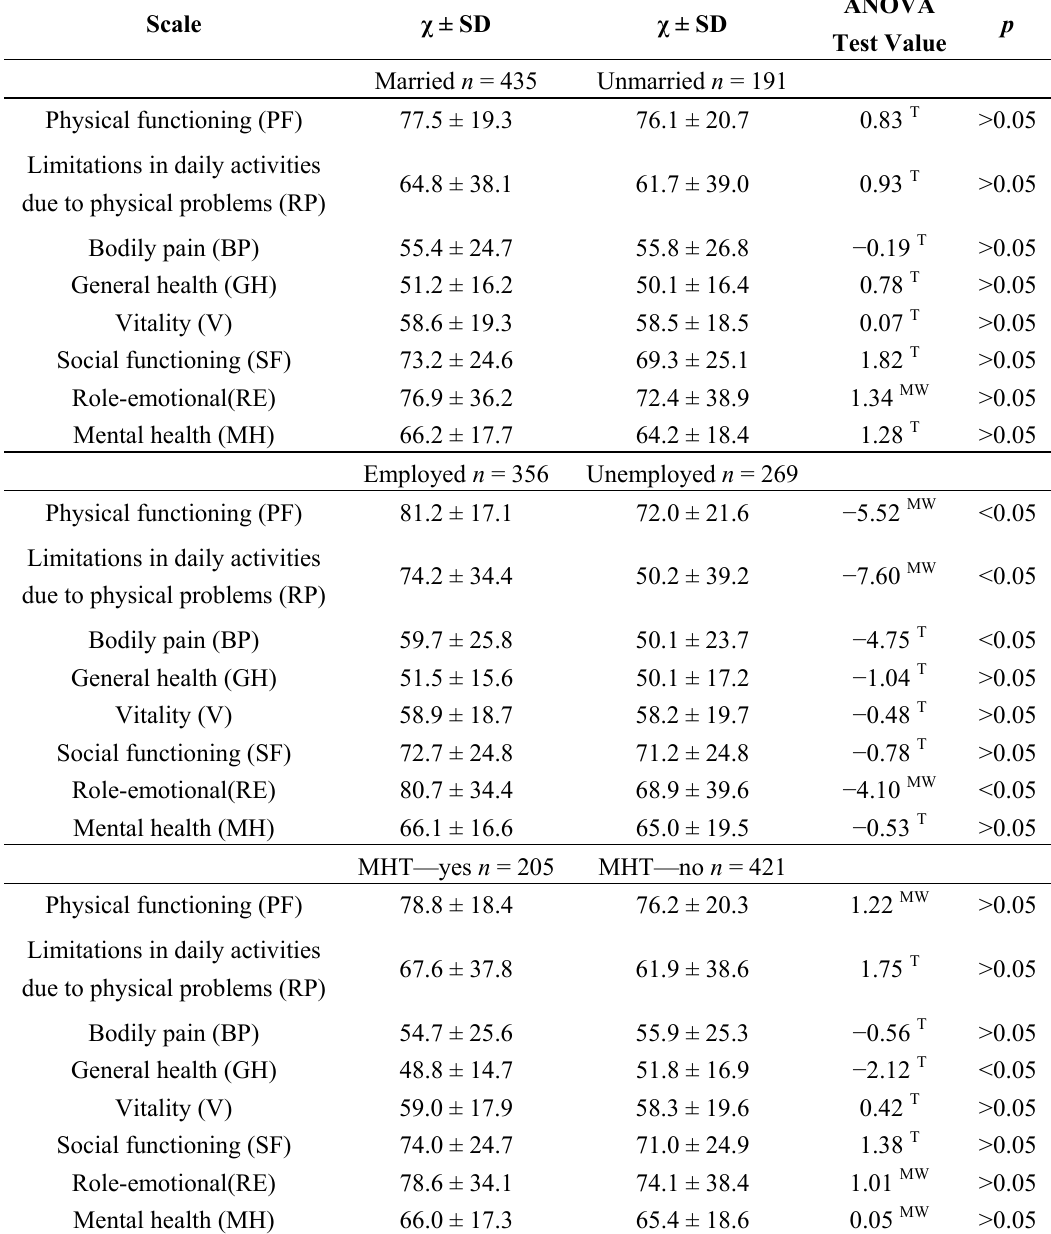
Table 6. Quality of life of respondents according to SF-36 with regard to marital status, employment and the use of